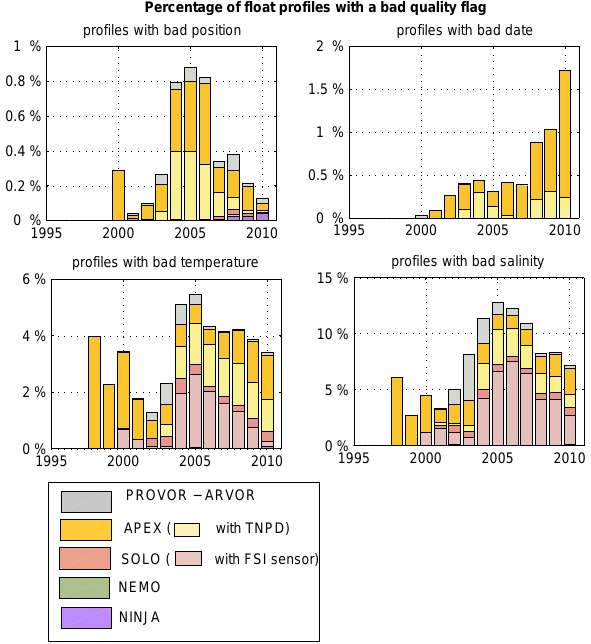
Fig. 11. Percentage of the Argo profiles with bad quality flags as a function of